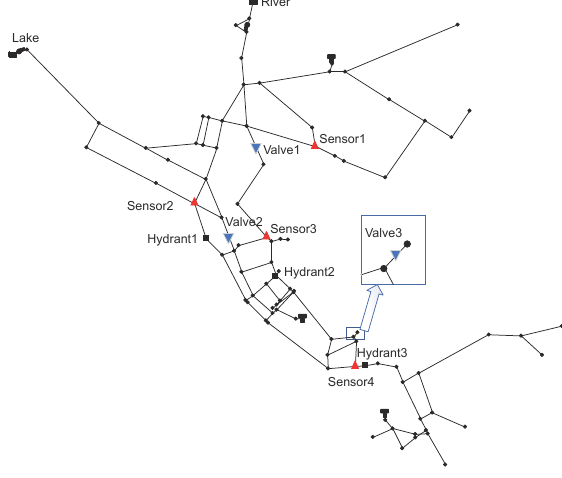
Fig. 3 Water distribution